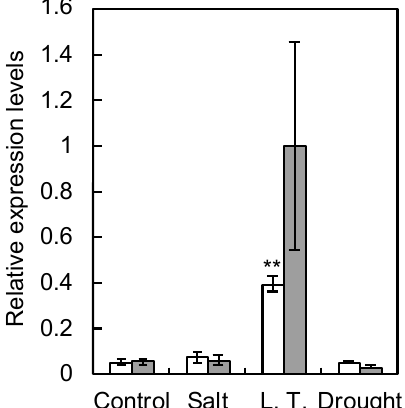
Figure 2. mRNA expression levels of PcLEA14 in pear leaves under environmental stress conditions for 24 h (white) and 48 h (grey): data shows the relative expression levels normalized against PcrRNA . Values indicate the mean ± standard error ( n = 6). ** Significantly different from control conditions at p < 0.01 according to the Dunnett’s test.